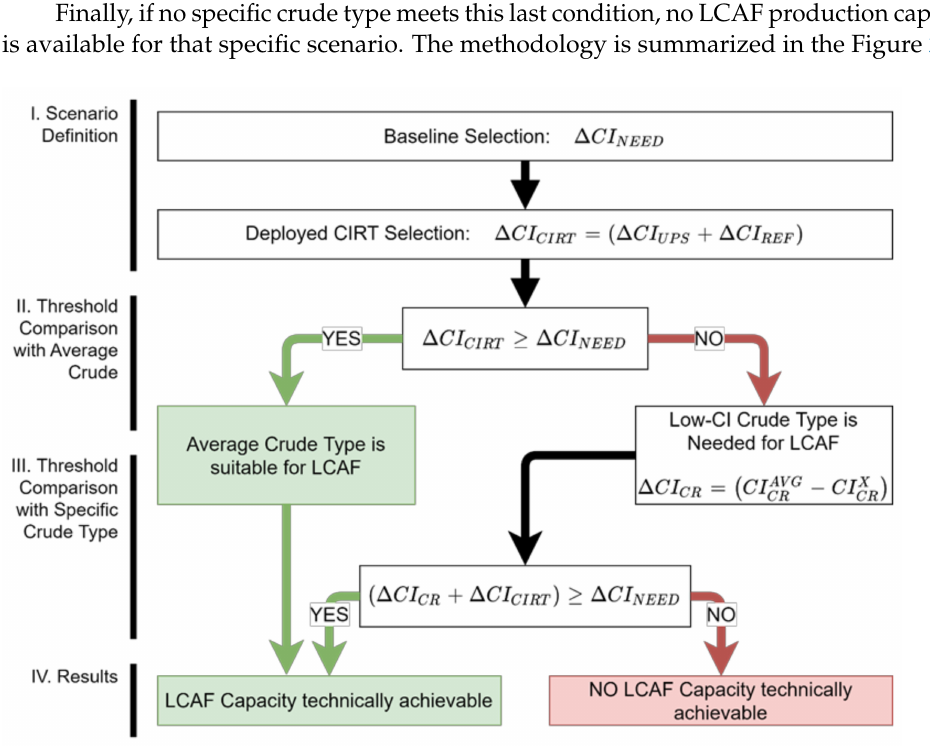
Figure 2. Flowchart describing the methodology adopted to evaluate the compliance of a specific scenario with LCAF CI